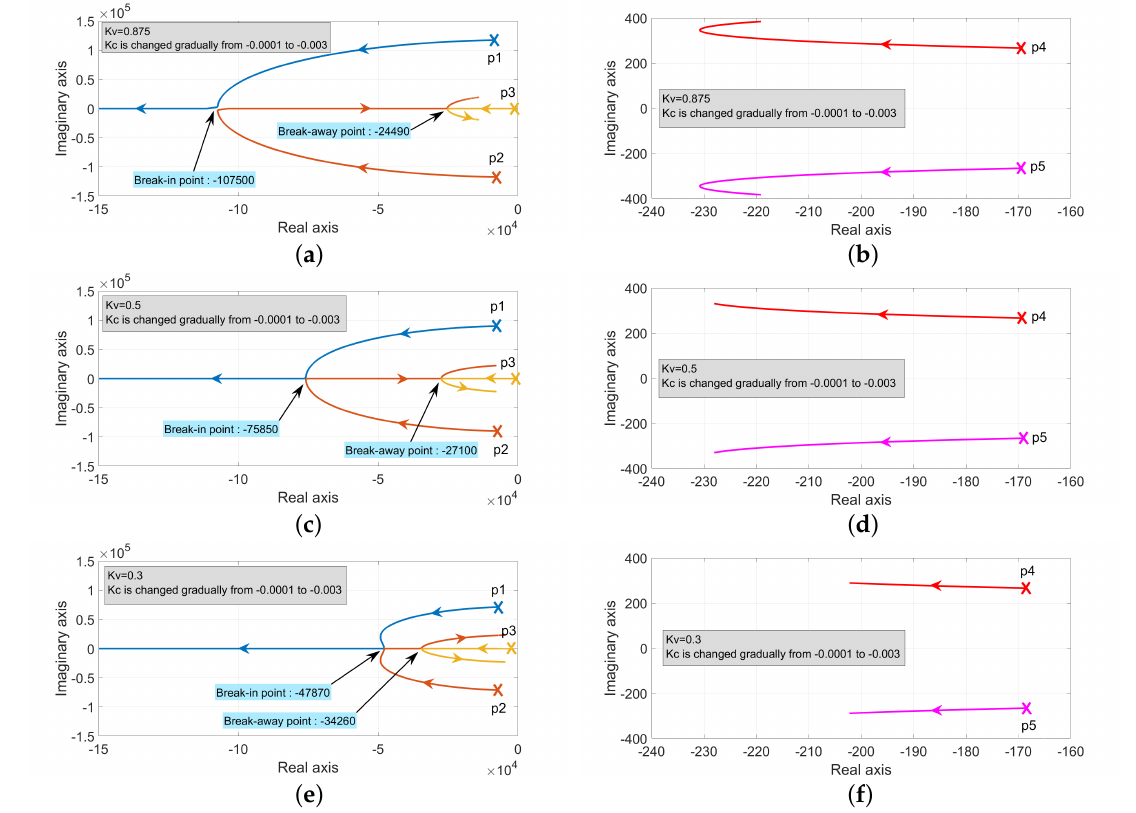
Figure 4. Root locus of closed-loop poles obtained when ( a , b ) K c is varied with K v = 0.875 , ( c , d ) K c is varied with K v = 0.5, and ( e , f ) K c is varied with K v =